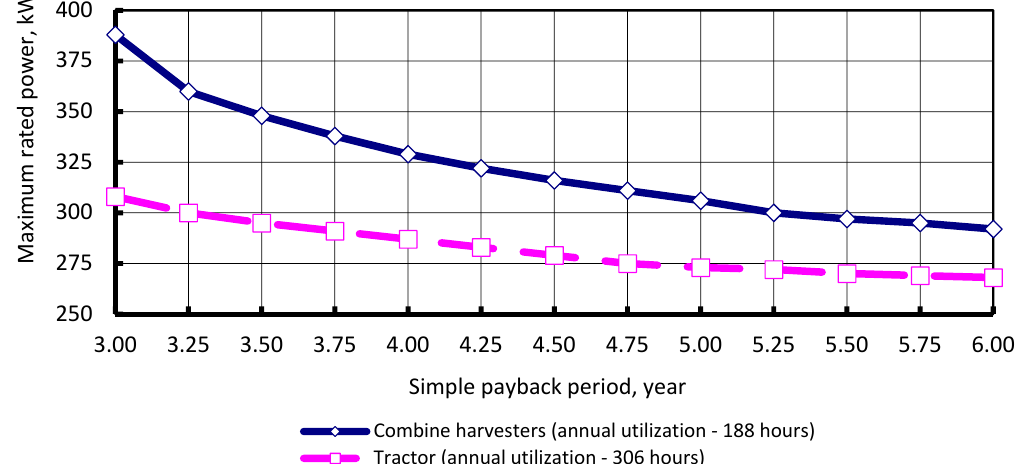
Figure 5. Maximum rated power (diesel fuel price—USD/L). Source: developed by authors.